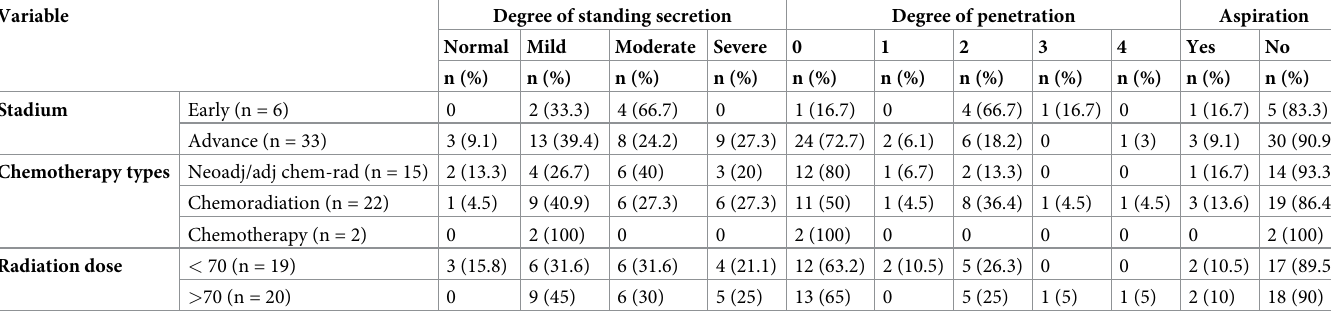
Table 5. FEES finding characteristics based on tumor stage, chemotherapy type, and radiation